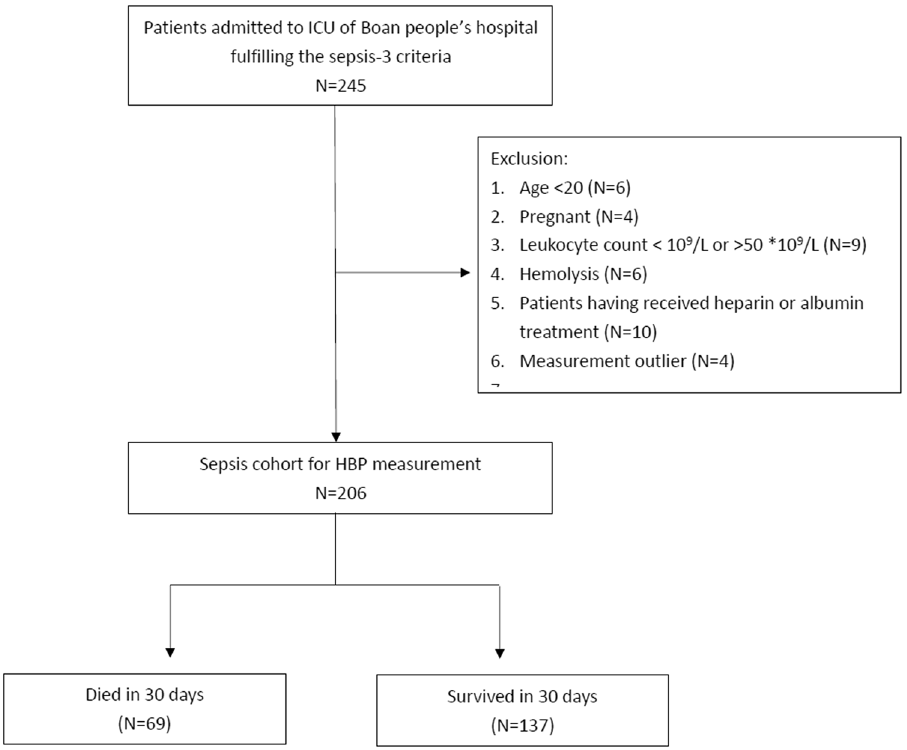
Figure 1. Cohort inclusion and exclusion